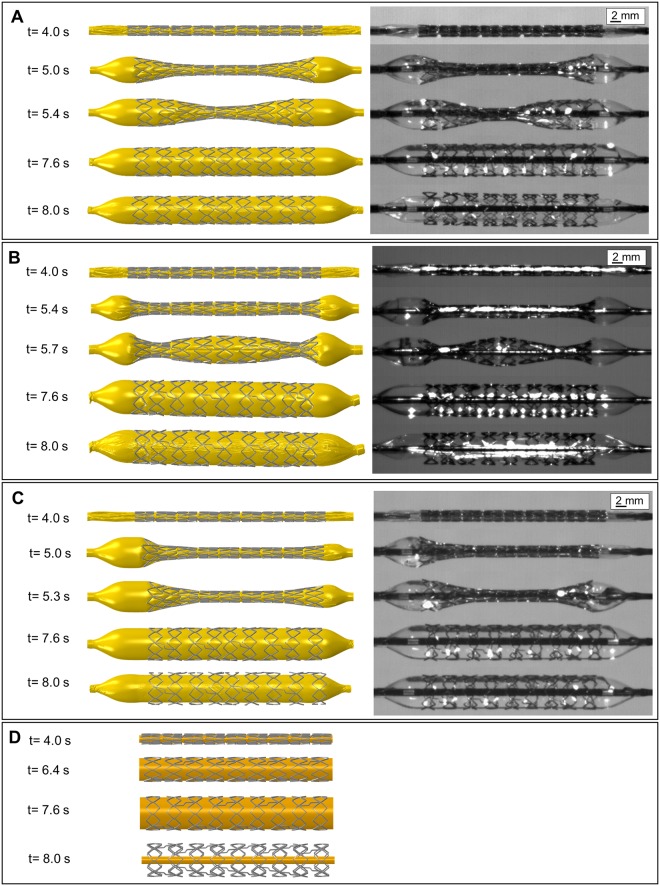
Comparison of the predicted stent expansion behavior (left) with high-speed recordings (right).A: Detailed stent life-cycle simulation of stent V1. B: Detailed stent life-cycle simulation of stent V2. C: Detailed stent life-cycle simulation of stent V1 with an assymmetric positioning of the stent on the balloon catheter D: Displacement-controlled expansion of stent V1. For reasons of conformity with Fig 10, the given time labels were related to the entire simulation of the stent life-cycle. Therefore, stent expansion starts at a step time t of 4 s.